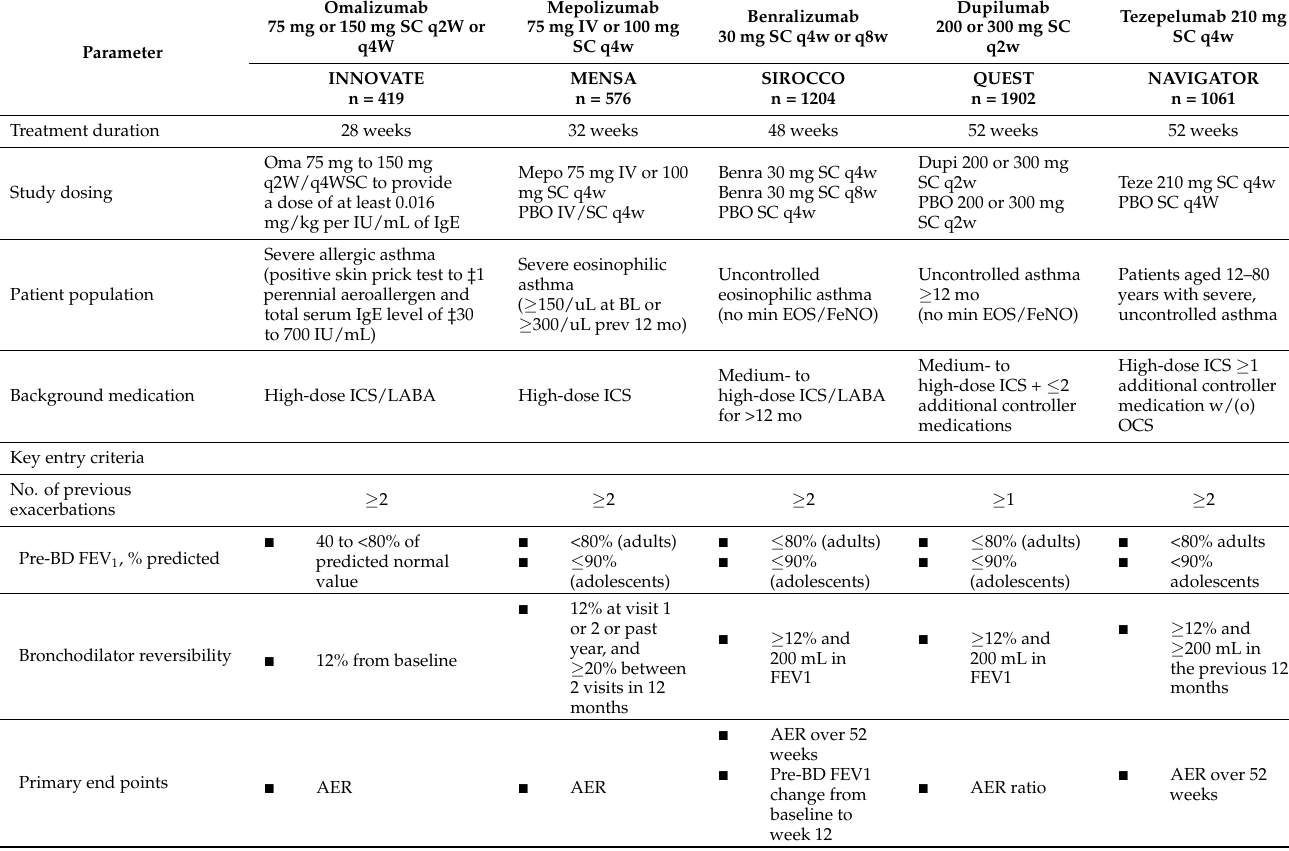
Table 3. Study design and key inclusion